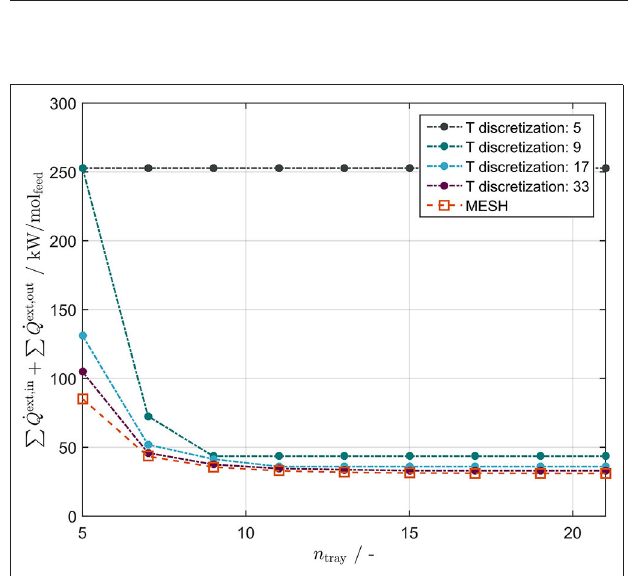
FIGURE 7 | Influence of number of separation stages on the total energy duty if no additional heat transfer is considered. Illustrated are the results of the FluxMax formulation considering different temperature discretizations (5, 9, 17, and 33 temperature levels) as well as of the classical MESH